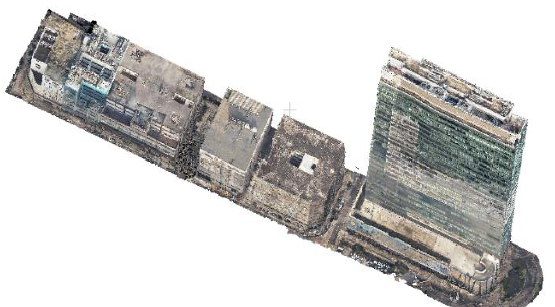
Figure 11. 3D mesh model generated from the integration of aerial, MMS, and backpack images.